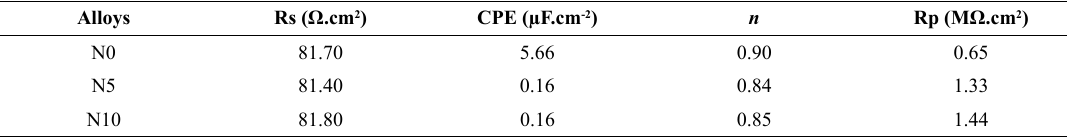
Figure 7. Nyquist diagram for the N0, N5 and N10 alloys obtained in open circuit potential. Table 6. Adjusted parameters of the equivalent circuit for Ni-Ti-Zr